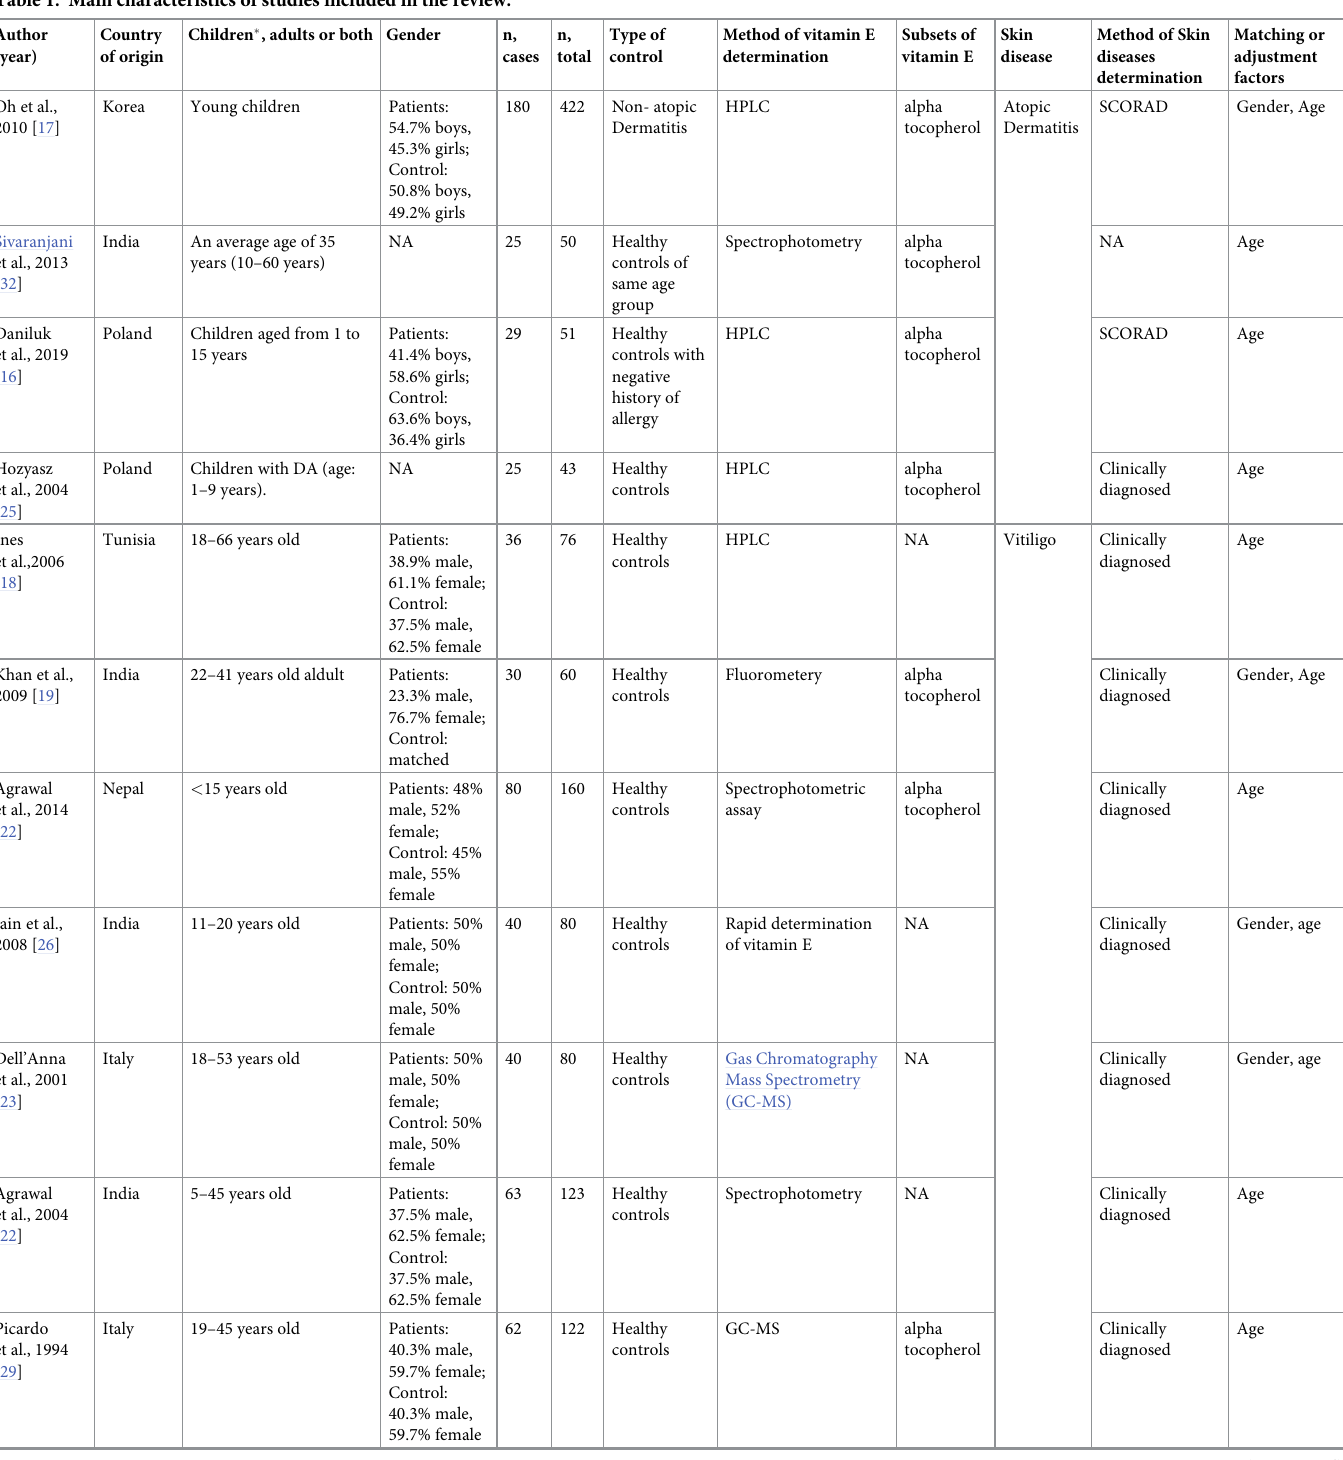
Table 1. Main characteristics of studies included in the